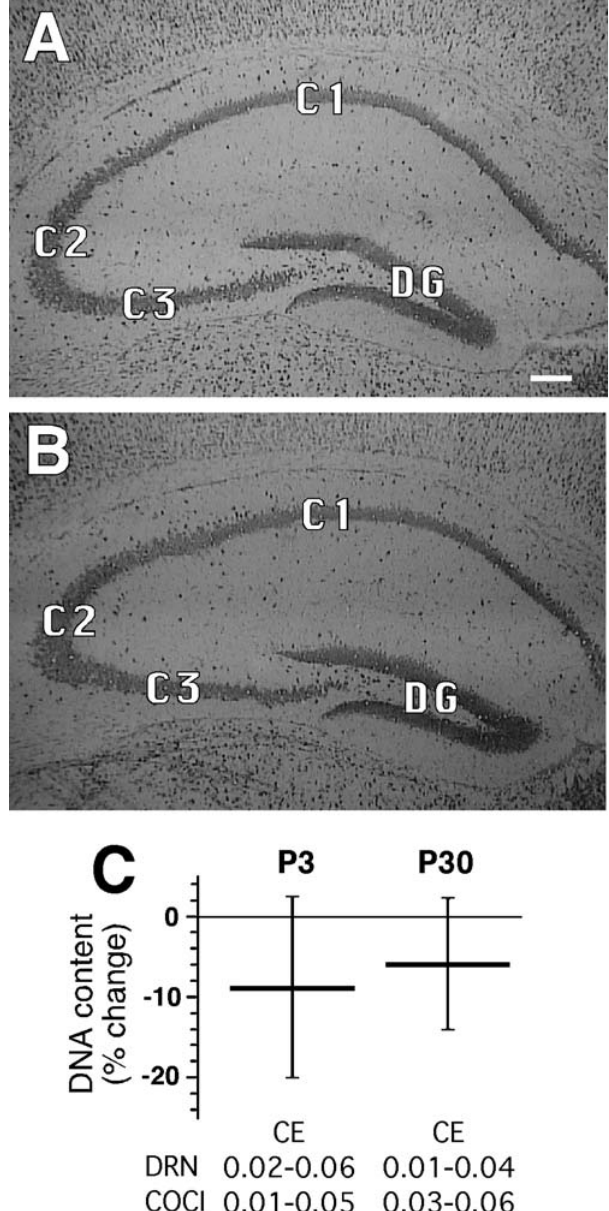
Figure 1. Evaluation of the structure and total DNA content of hippocampal pyramidal tissues in P3 progeny of saline-treated and cocaine-treated mice. (a) Typical micrograph of HistoGene- stained coronal section through the hippocampus of a P3 Saline pup. (b) Micrograph of a comparable section from an age-matched offspring of a cocaine-treated mother. (c) Relative amounts of total DNA content between the offspring of saline-treated and cocaine-treated mothers at P3 and P30. Horizontal bars show mean difference in DNA content between Cocaine and Saline groups at each age, while vertical bars show the SEM (n =10/group/age). For either age group, the inter- sample ranges of coefficient of error (CE) values are provided at the bottom of the chart. C1, C2, C3, hippocampal regions; DG, dentate gyrus. Note the absence of detectable histological differences between micrographs a and b